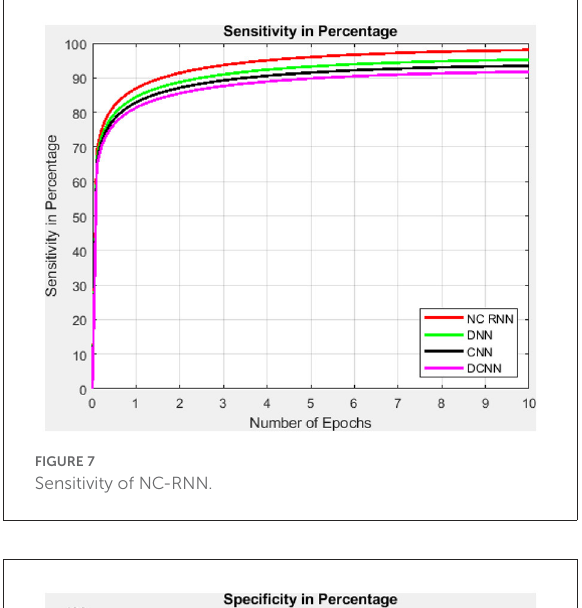
FIGURE5 Flow diagram of NC-RNN.